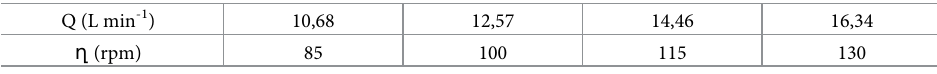
Table 2. Results obtained with the hydraulic system bench test in simulation